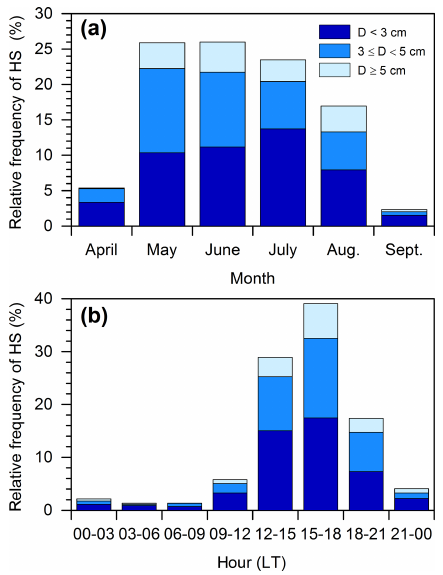
Figure 2. (a) Seasonal and (b) diurnal (local time; LT) cycle of HS tracks (SHY of 2004–2014) depending on the hail size diameter according to ESWD